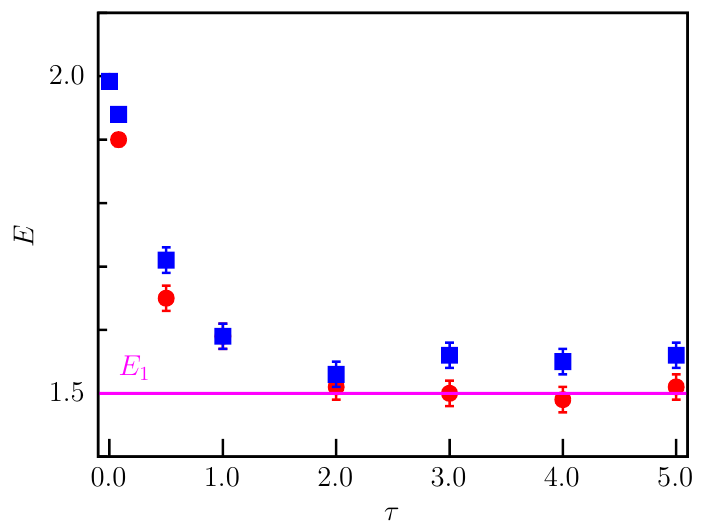
Figure 6: Evolution of estimates of the first-excited state energy for the harmonic oscillator as a function of the imaginary time τ . The circles stand for results when the image action is employed. The squares represent these quantities without using the image action correction in the simulations. Error bars, when not visible, are smaller than the size of the symbol. The mixed estimator was used in both cases. The line = 3 / shows the analytical value of the first excited-state energy E 1